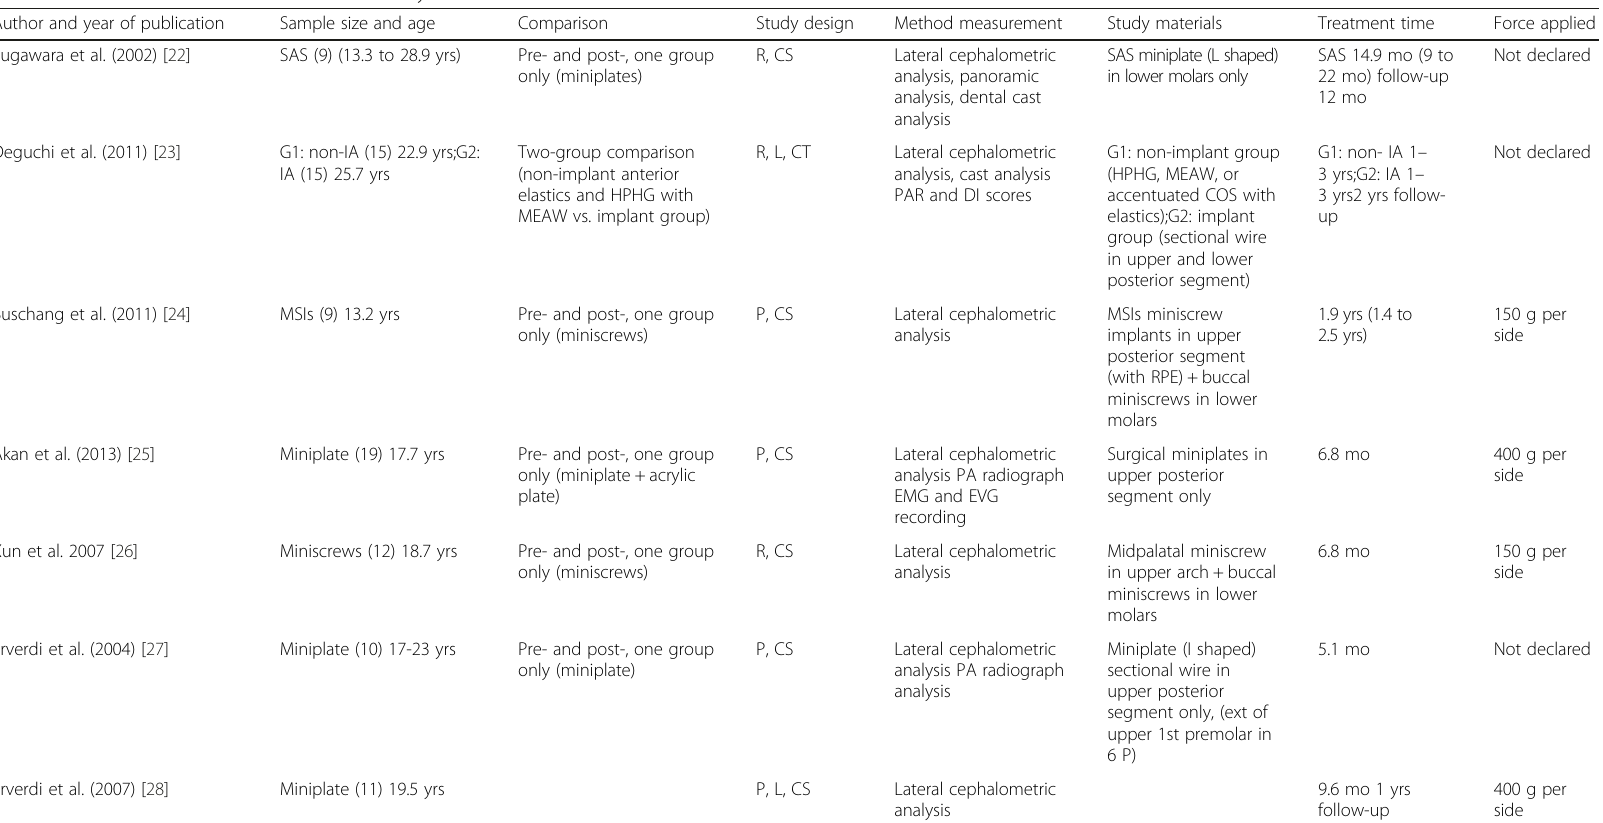
Table 3 Characteristics of studies included in systematic